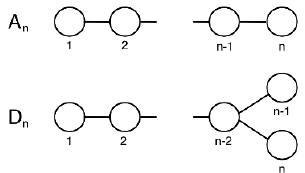
Figure 1. Dynkin diagrams of the A n and D n Lie